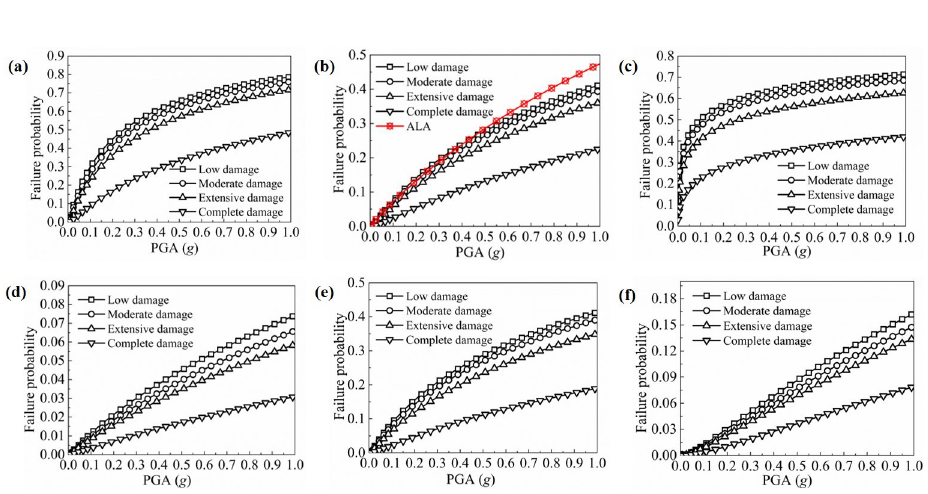
Fig 6. Fragility of various pipe components in different soil. (a) SE, (b) SCP-1, (c) CE, (d) ST, (d) SCP-2, (f) CT.